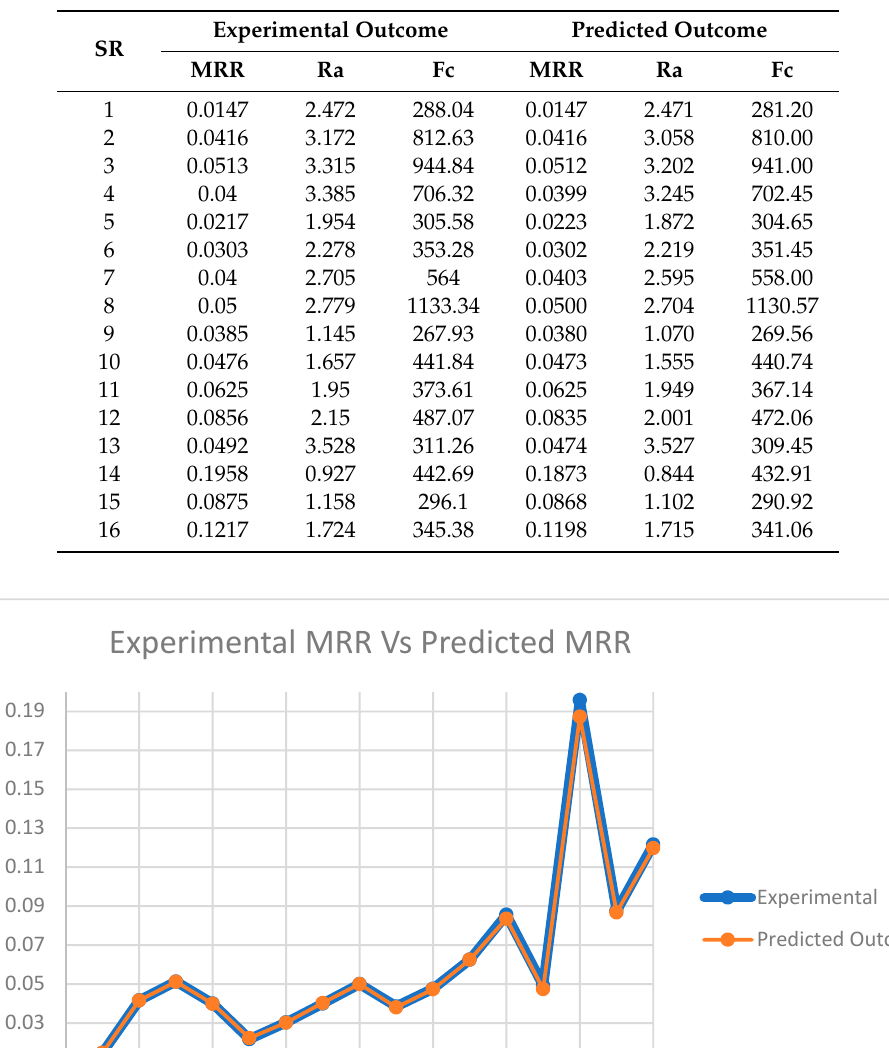
Table 7. Experimental and predicted results.